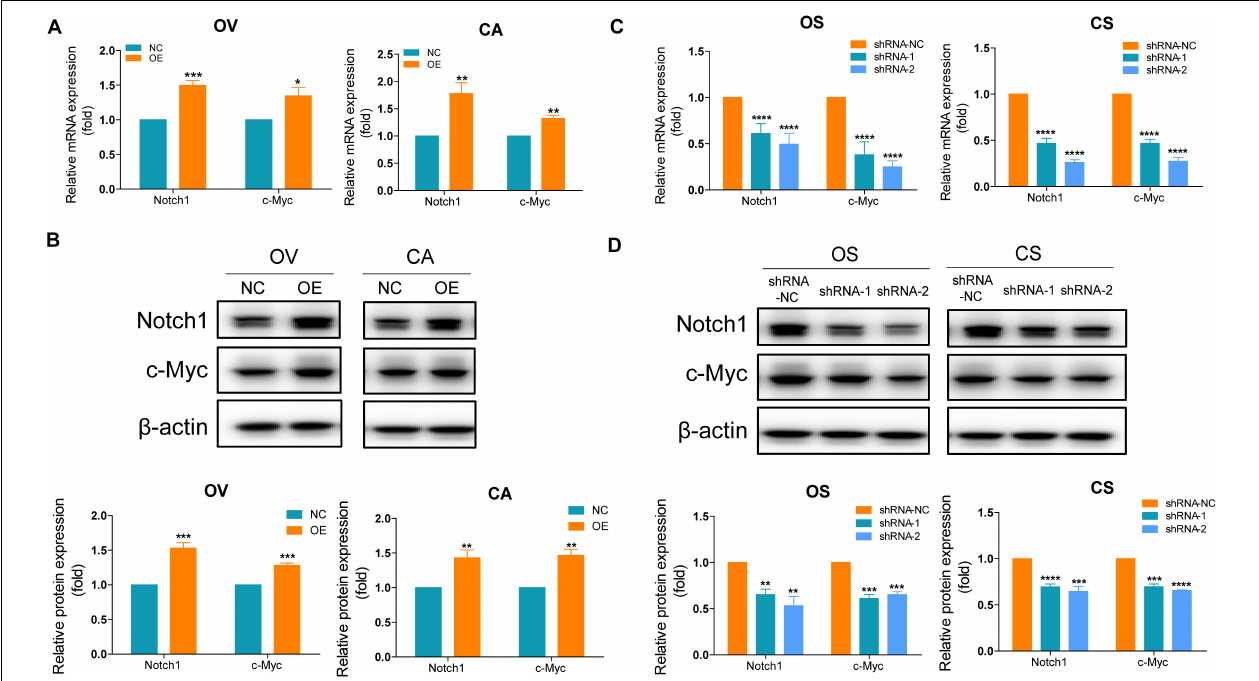
FIGURE 6 | SNORA72 induces the stemness of ovarian cancer by activating the Notch1/c-Myc pathway. (A) Relative mRNA expressions of Notch1 and c-Myc to β -actin, as an endogenous control, analyzed by quantitative reverse transcription PCR (qRT-PCR) in OVCAR-3 (OV) and CAOV-3 (CA) cells after transfection of the transfected (OE) or control (NC) plasmids for 48 h. The expression level in OV and CA cells after transfection of NC plasmids was set as 1. (B) Relative protein expressions of Notch1 and c-Myc to β -actin analyzed by Western blot in OV and CA cells after transfection of the OE or NC plasmids for 48 h. The expression level in OV and CA cells after transfection of NC plasmids was set as 1. (C) Relative mRNA expressions of Notch1 and c-Myc to β -actin analyzed by qRT-PCR in OVCAR-3 spheroid (OS) and CAOV-3 spheroid (CS) cells after transfection of the shRNA-1, shRNA-2, or shRNA-NC plasmids for 48 h. The expression level in OS and CS cells after transfection of shRNA-NC plasmids were set as 1. (D) Relative protein expressions of Notch1 and c-Myc to β -actin analyzed by Western blot in OS and CS cells after transfection of the shRNA-1, shRNA-2, or shRNA-NC plasmids for 48 h. The expression level in OS and CS cells after transfection of shRNA-NC plasmids was set as 1. * P < 0.05, ** P < 0.01, *** P < 0.001, and **** P < 0.0001.